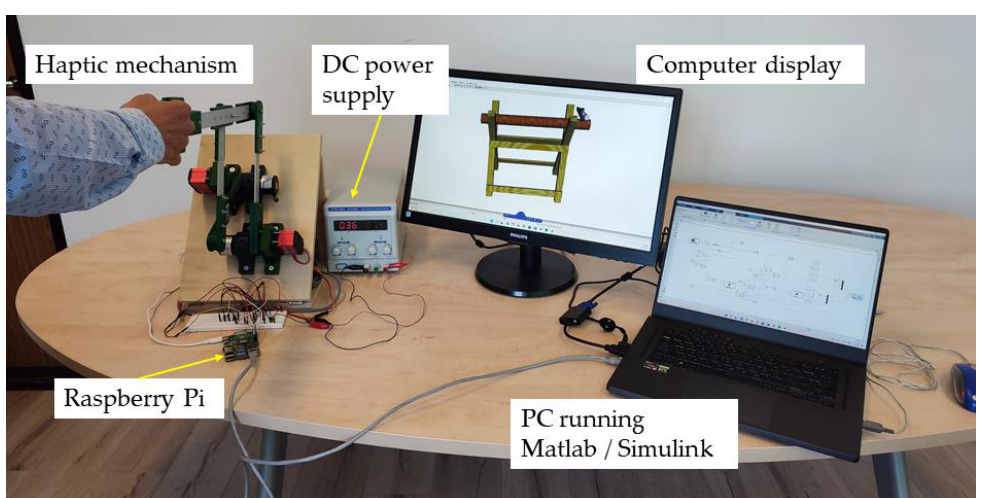
Figure 15. Overview of the experimental equipment.